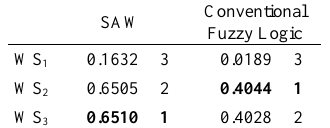
Table 12. Result comparison for Case